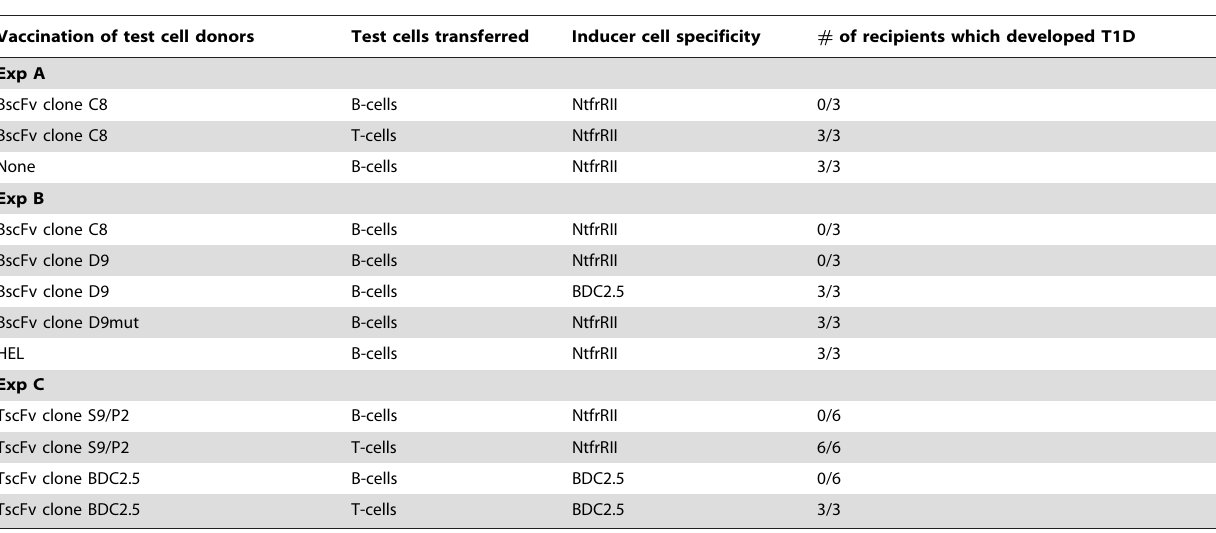
Table 2. Adoptive transfer of type 1 diabetes to NOD-SCID recipients by diabetogenic CD4 + T-cells (inducer cells) can be prevented by B- but not T-cells (test cells) from donors immunized with scFvs if the specificity of the scFv and the inducer cell are